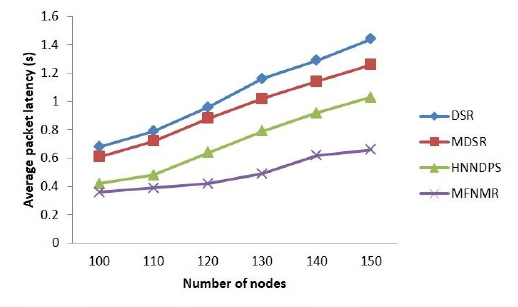
Figure 4. Average Packet Latency Analysis based on Number of